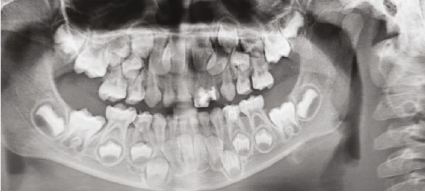
Figure 3: Panoramic radiograph showing the morphology of tooth 22 with a slight developmental delay and rotation.